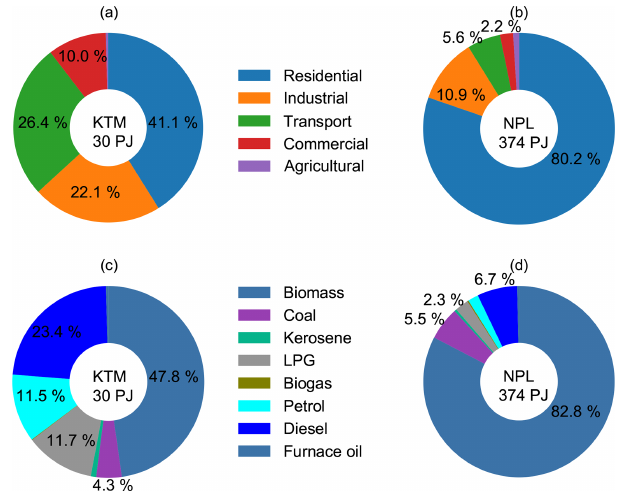
Figure 4. Energy consumption comparison at sectoral level for the Kathmandu Valley and Nepal in (a) and (b) and for different fuels (c) and (d) for year